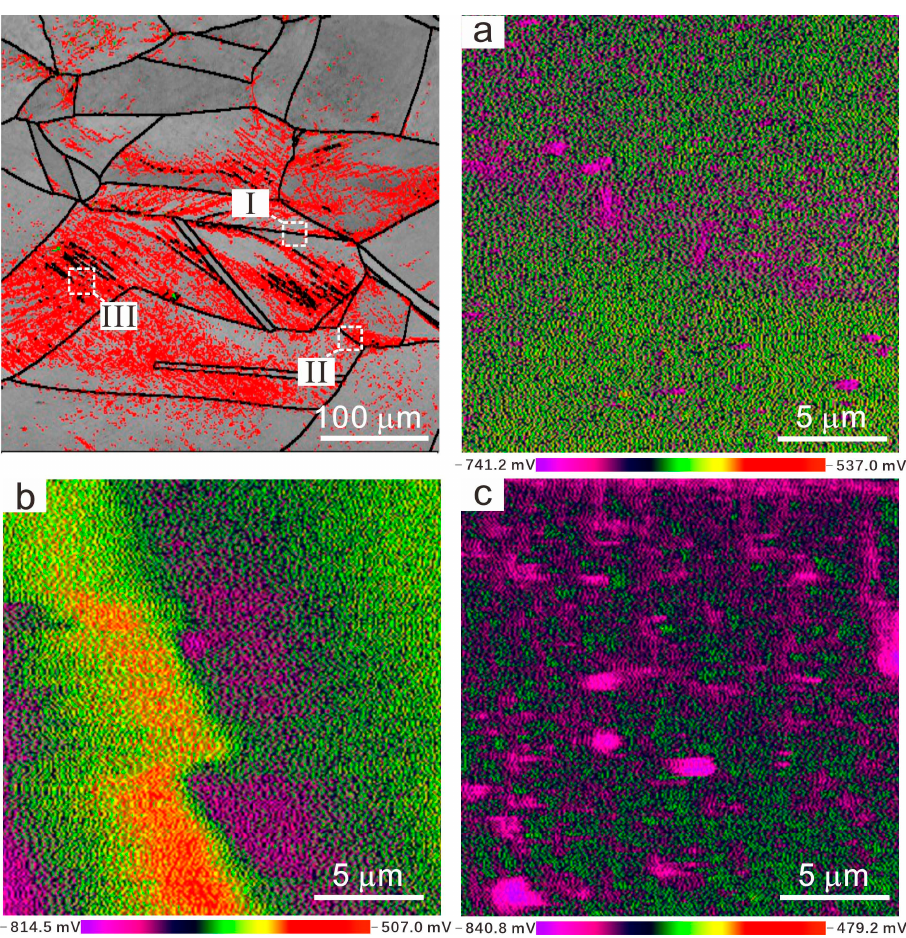
Figure 7. The low-angle grain boundary distribution and the Volta potential of the selected regions for a copper sample with 20% deformation. In the EBSD image of 20% deformed copper. The Volta potential of regions I, II and III with different grain boundary distribution were measured to obtain the corresponding potential distribution maps ( a ), ( b ) and ( c ).